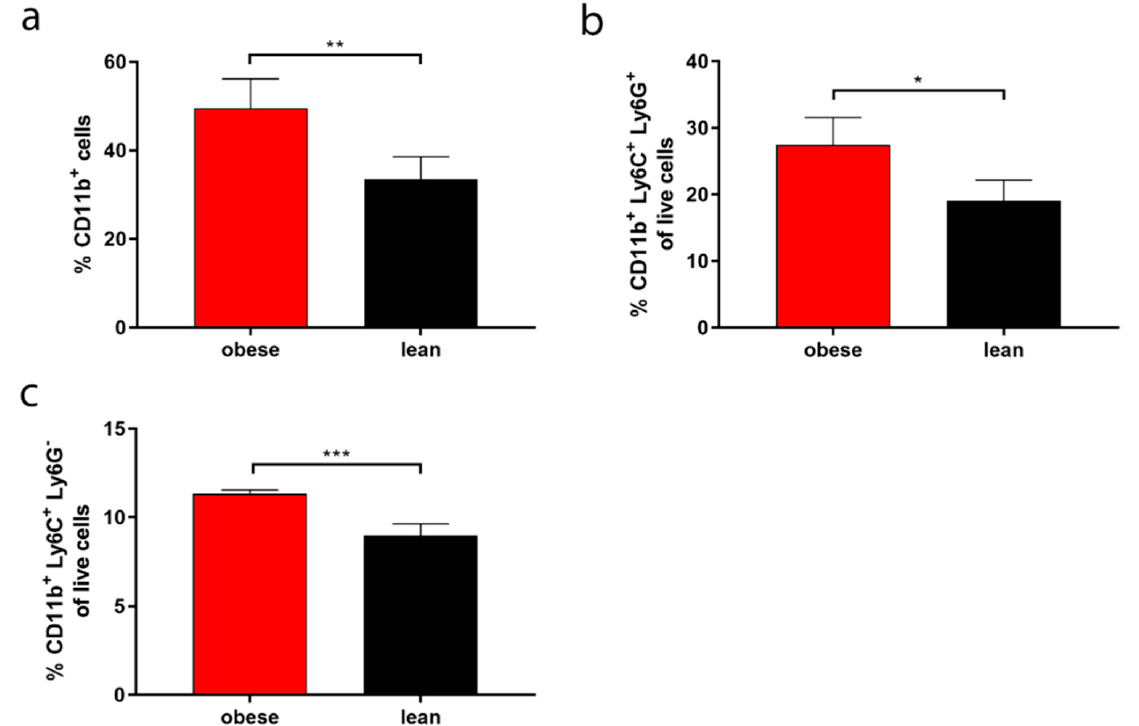
Figure 1. Obese mice had elevated levels of myeloid cells in the bone marrow as compared with lean mice. Bone marrow cells were isolated from obese and lean mice and analysed for the frequency of ( a ) CD11b + cells; ( b ) CD11b + Ly6C + Ly6G + cells (inflammatory monocytes) and ( c ) CD11b + Ly6C + Ly6G − cells (neutrophils) by flow cytometry. Frequencies are shown as a percentage of live cells. Data are the mean + STD from four independent repeats, with 1 female mouse/repeat. Unpaired student’s t -test: *** p < 0.001, ** p < 0.05, * p < 0.01.